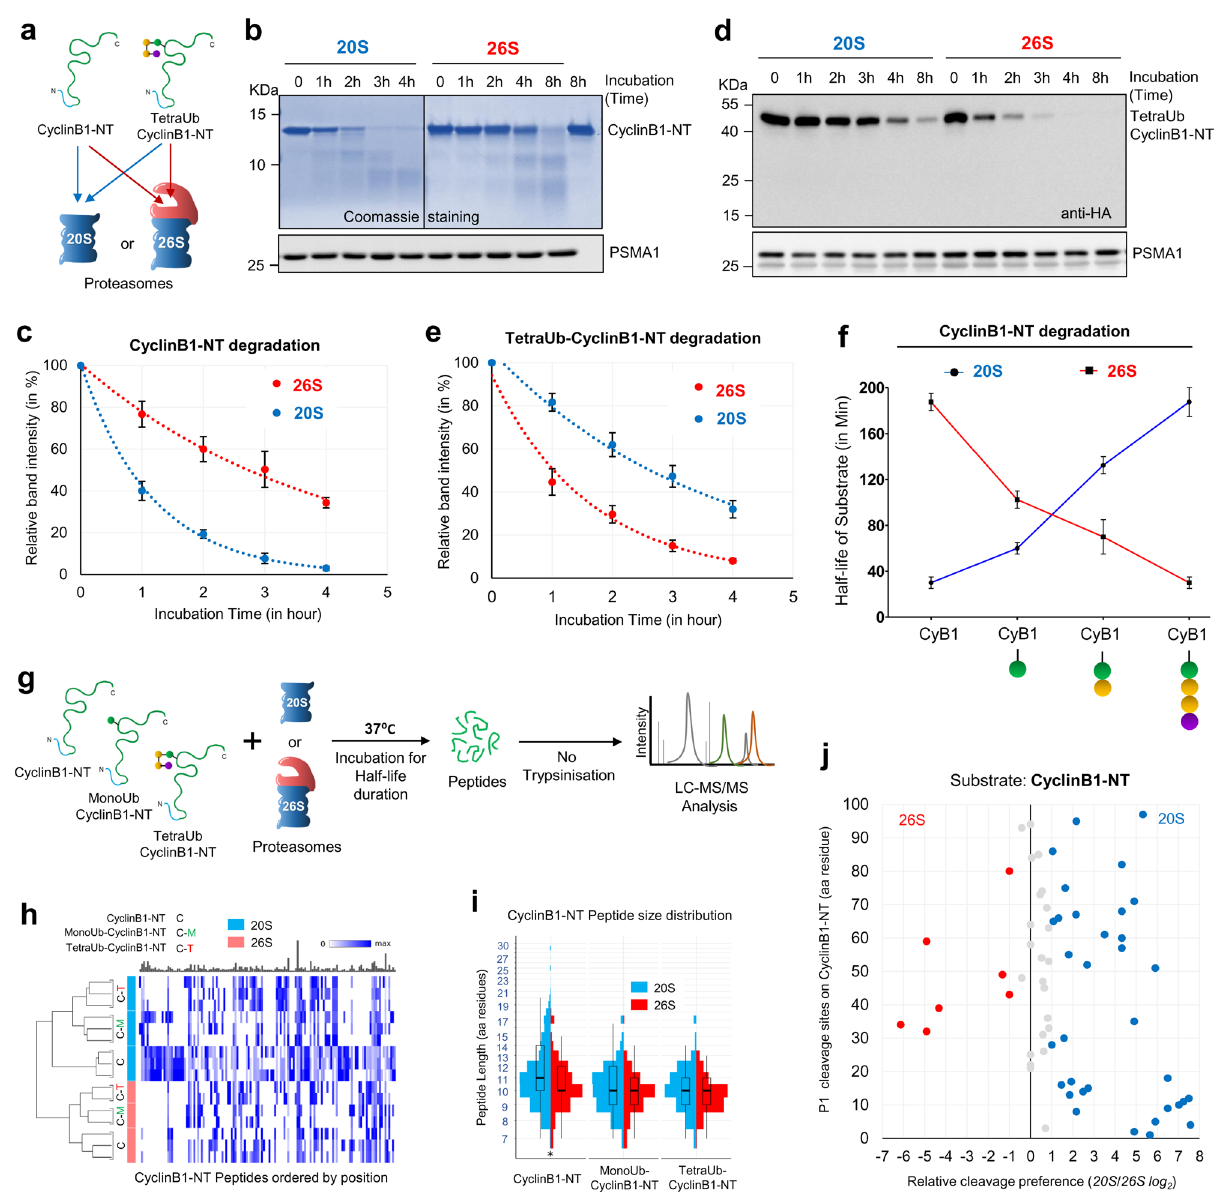
Fig. 1 Chemical synthesis and ubiquitination of ubiquitin-conjugates. a A cartoon depicting cyclin B1 with its 1 – 88 aa residue unstructured N-terminal region (NT), and a C-Terminal CDK1 binding region (left). The primary amino acid sequence of the N-terminal region of cyclin B1 that encompasses the Degron and 15 Lysine residues (right). Below are the wild-type (WT) and K0-mutant (all Lysine to Arginine) Cyclin B1-NT sequences used in this study for mammalian cell expression. The K64 HA-Cyclin B1-NT sequence was used for chemical ubiquitination of substrates (bottom). b Schematic illustration of the strategy used to synthesize differentially tagged TetraUbK48-HA-Cyclin B1-NT (Nbz = N-acyl-benzimidazolinones, SR = 3-mercaptopropionic acid). The detailed chemical synthesis protocol is described in Supplementary Methods. c A cartoon representation of a set of four synthetic substrates designed to study proteasome function. Tagged (Myc/Flag) and/or untagged ubiquitin units were attached to lysine64 of the HA-Cyclin B1-NT to obtain ubiquitinated conjugates. The numbers 3, 5, and 7 correspond to the three synthetic substrates in panel ( b ) (see also Supplementary Methods). d All four synthetic ubiquitinated Cyclin B1-NT conjugates were resolved by SDS-PAGE and stained with Coomassie or probed with the indicated antibodies for immunoblotting (IB). e Human 30S/26S and 20S proteasomes puri fi ed from human erythrocytes were resolved by native gel for in-gel activity (left), or for Coomassie (center), or resolved by SDS-PAGE for Coomassie staining. The band marked by * near 90 kDa was identi fi ed as HSP90AA1 and HSP90AB1 in MS/MS analysis. All other bands were con fi rmed to contain primarily 20S (right) or 26S (to its left) subunits. Source data are provided as a Source data fi